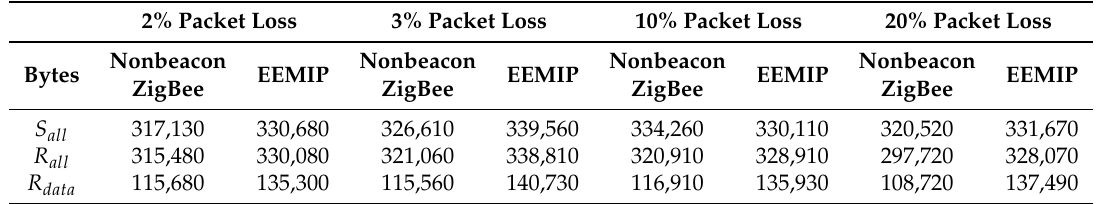
Table 10. Simulation data for a more realistic scenario with various amount of congestion.